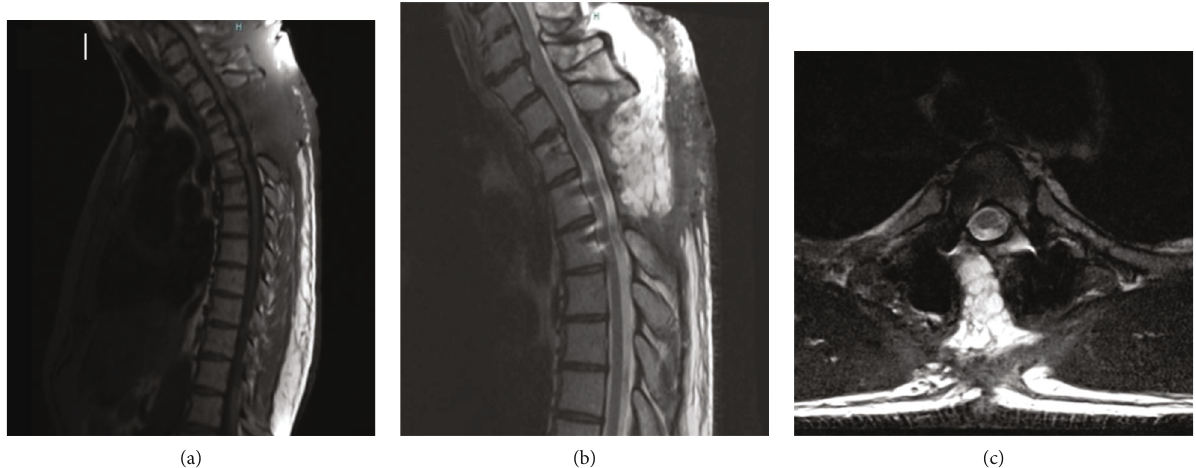
Figure 3: Sagittal, precontrast (a) and postcontrast (b), and axial postcontrast (c) MRI sequences 3 months postoperatively demonstrating maintained surgical decompression and no recurrent cyst